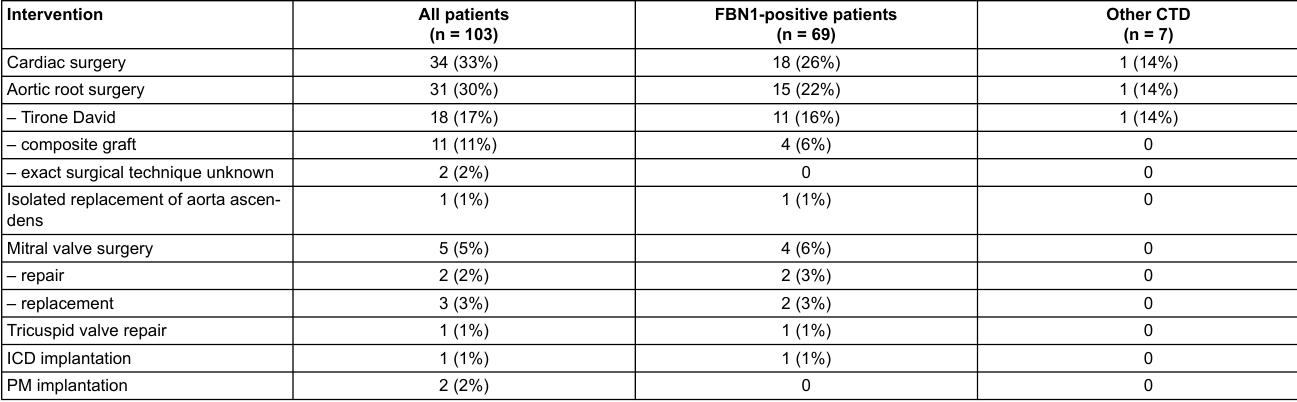
Table 5: Summary of cardiac interventions. Intervention All patients